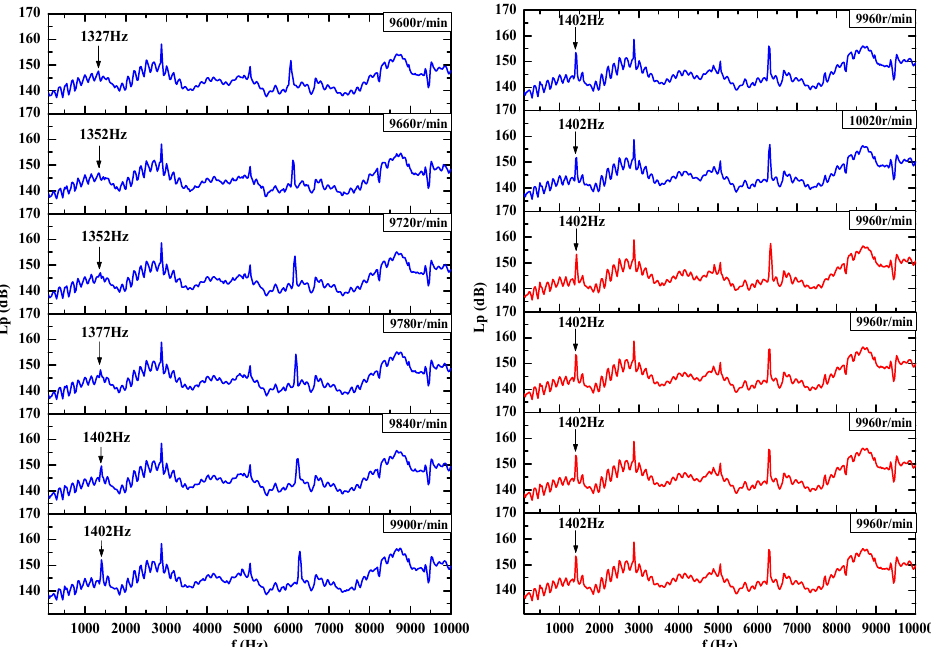
Figure 4. The change of noise signal spectrum before and after rotor blade abnormal vibration.